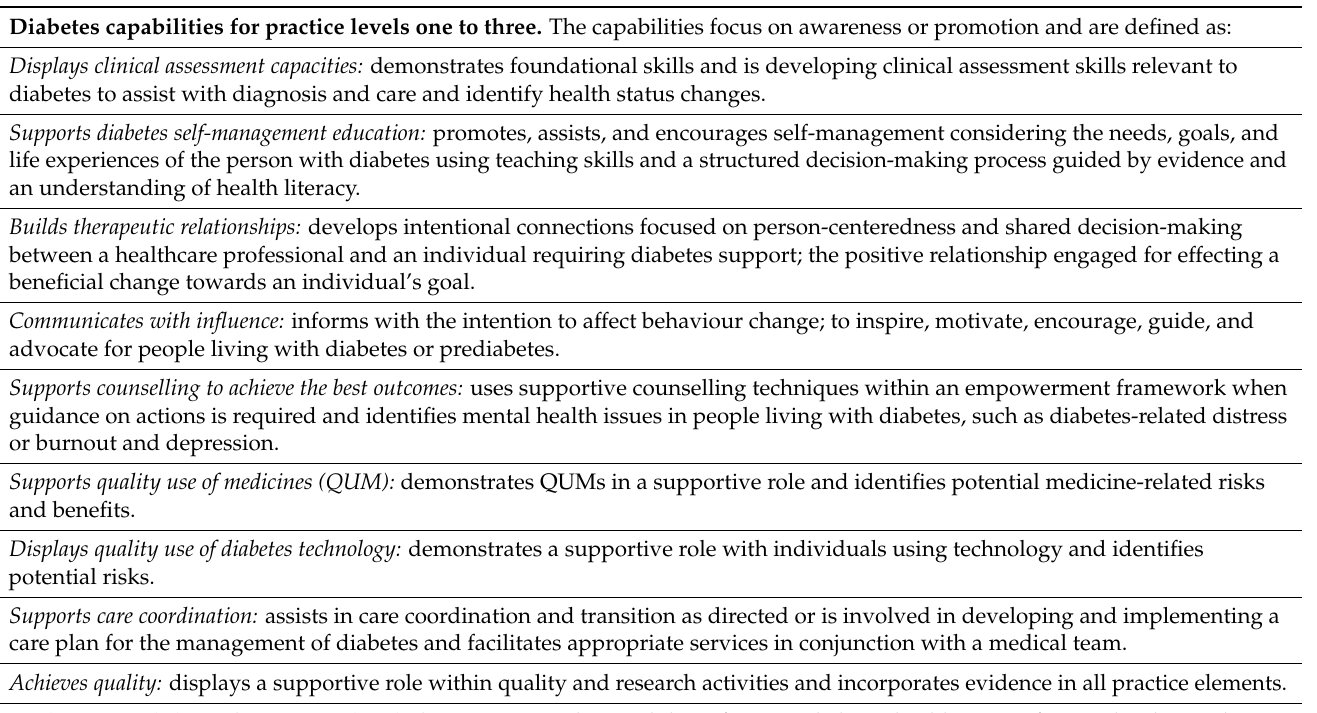
Table 1. Nine capabilities required to deliver and support diabetes care and their